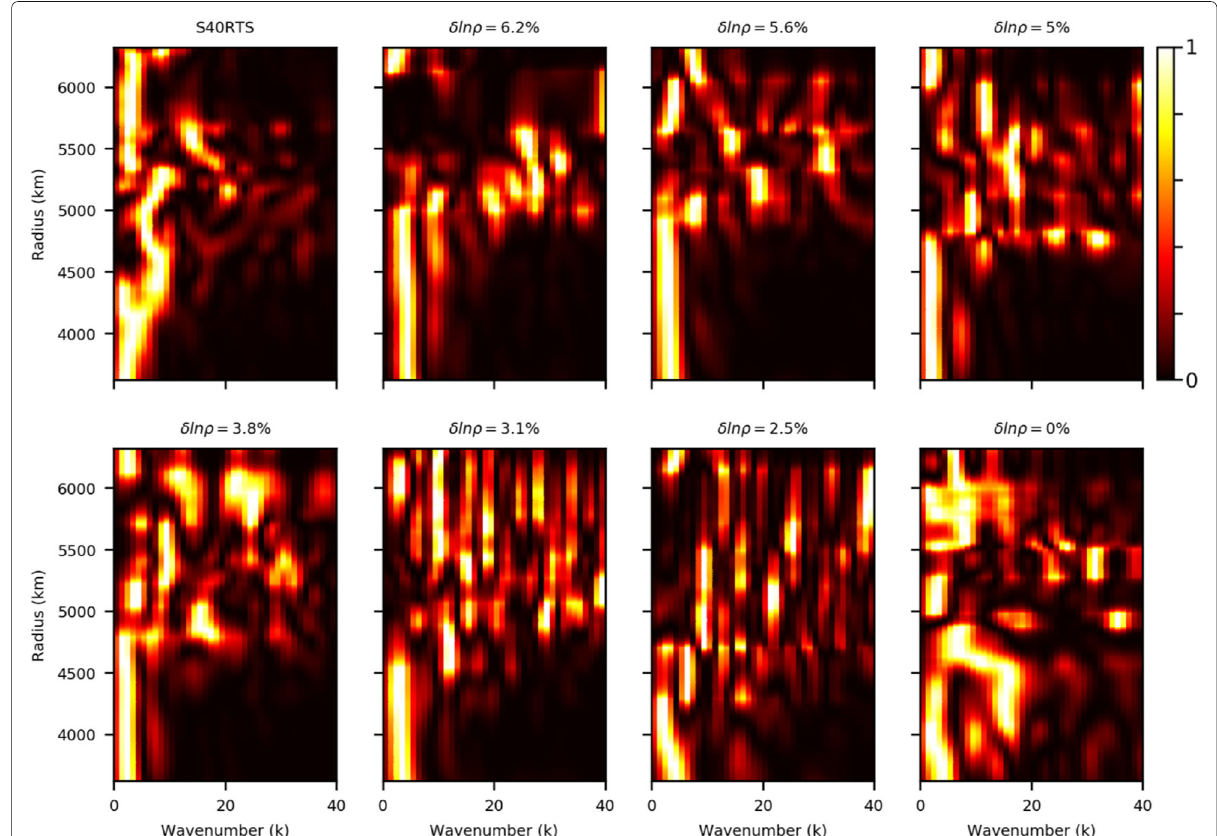
Fig. 6 Power spectral density plots for S40RTS and the tomographically filtered models as imaged beneath the African plate. Spectral power is normalized to the maximum power at each depth and plotted as a function of wavenumber and radius. Same basic features as for mantle beneath the Pacific except that S40RTS has more power at low wavenumbers in the upper mantle as well as in the lower mantle